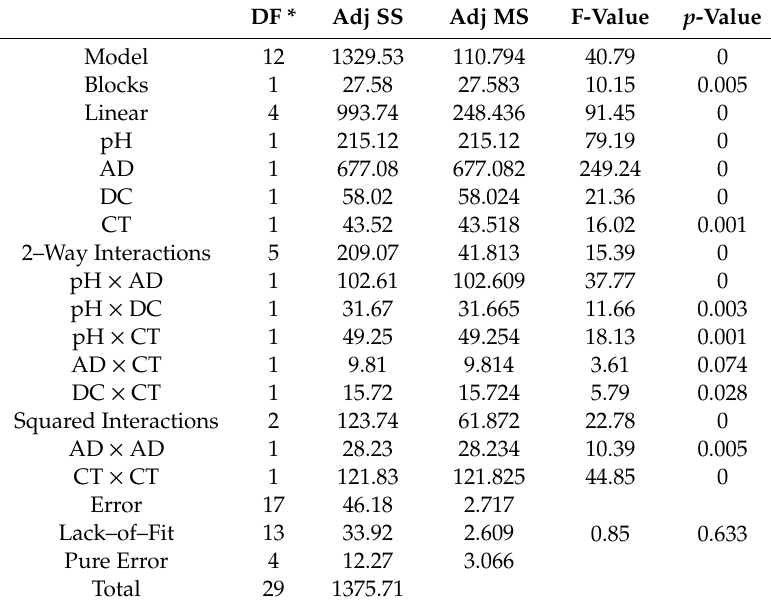
Figure 1. Pareto chart of standardized effects following response transformation. Table 4. Analysis of variance (ANOVA) for the transformed